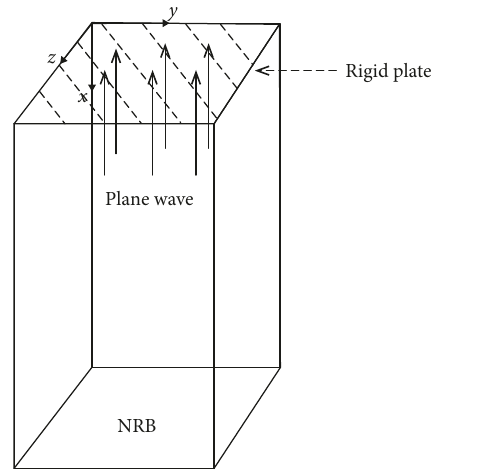
Figure 5: Bleich–Sandler